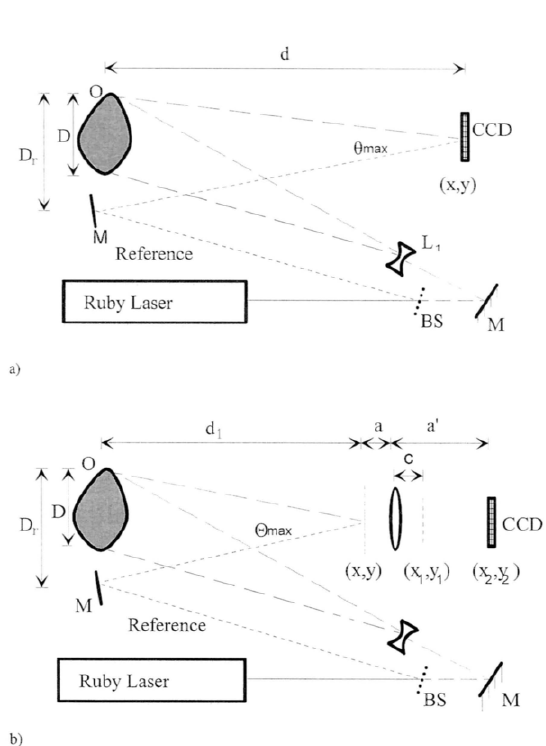
FIGURE 11 Experimental setup for double-pulsed ruby laser digital holographic interferometry: (al with out magnification of the interference pattern and (b) with magnification of the interference